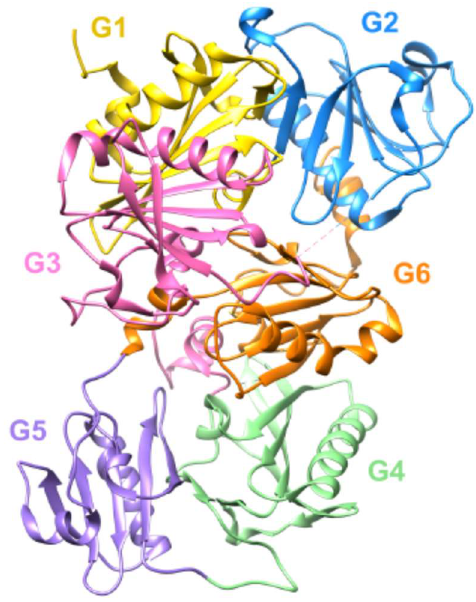
Figure 1. Structure of the six homologue domains of GSN. Schematic representation of the structure of Ca-free human gelsolin (PDB ID code: 3FFN) [37].